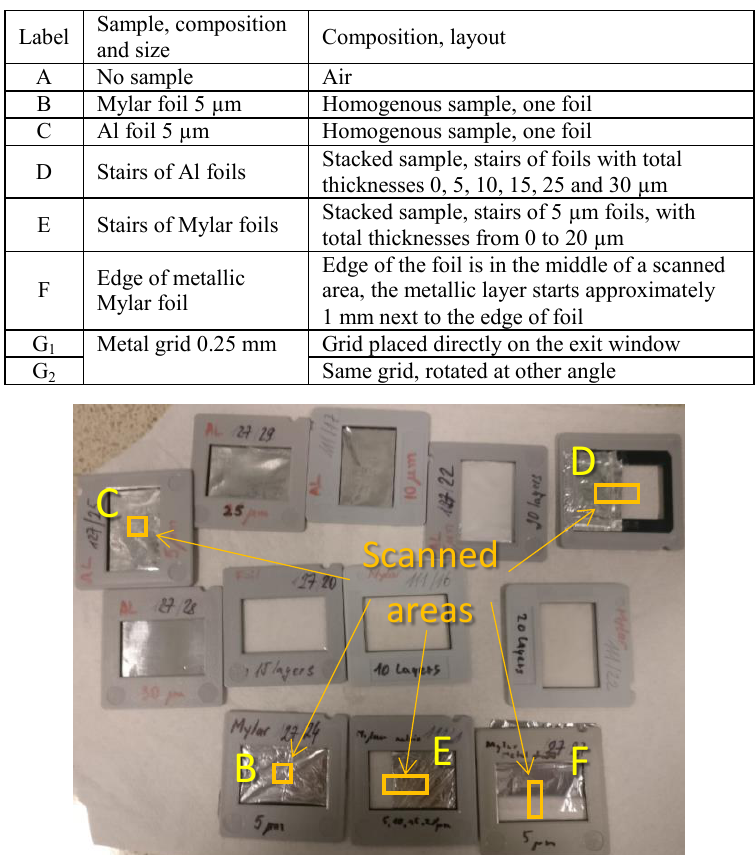
Fig. 2. Imaging samples used: simple Mylar foil 5 µm (B); simple Aluminium foil 5 µm (C); stair of Aluminium foil (0, 5, 10, 15, 25 and 30 µm) (D); stairs of Mylar foil (0, 5, 10, 15 and 20 µm) (E); edge of 5µm Mylar foil (F). Orange rectangles and squares represent the scanned areas.